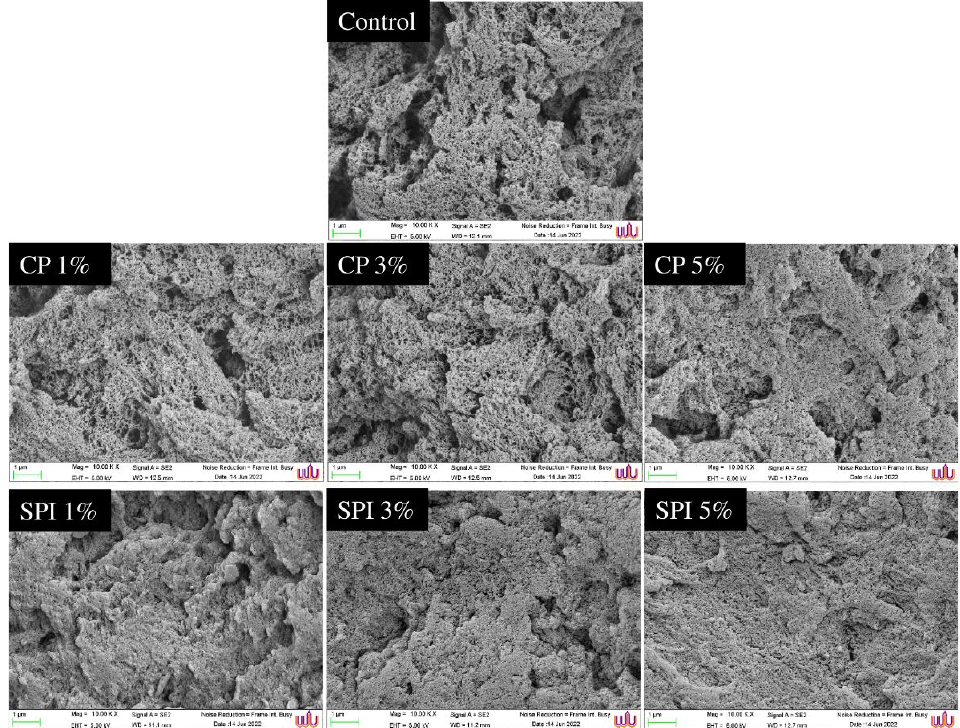
Figure 5. Effects of the addition of cricket powder (CP) and soy protein isolate (SPI) at different levels on the microstructure of surimi gels. (Magnification: 10,000×, EHT: 3